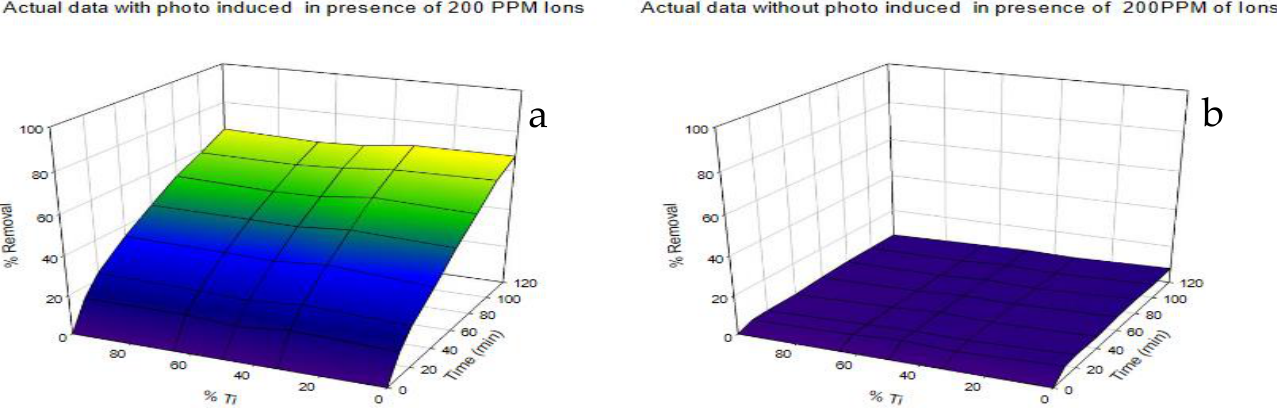
Figure 7. Three-dimensional curves of removal of 100 ppm ions with 10 ppm dye in the presence and absence of UV irradiation: ( a ) under UV irradiation; ( b ) without UV irradiation.